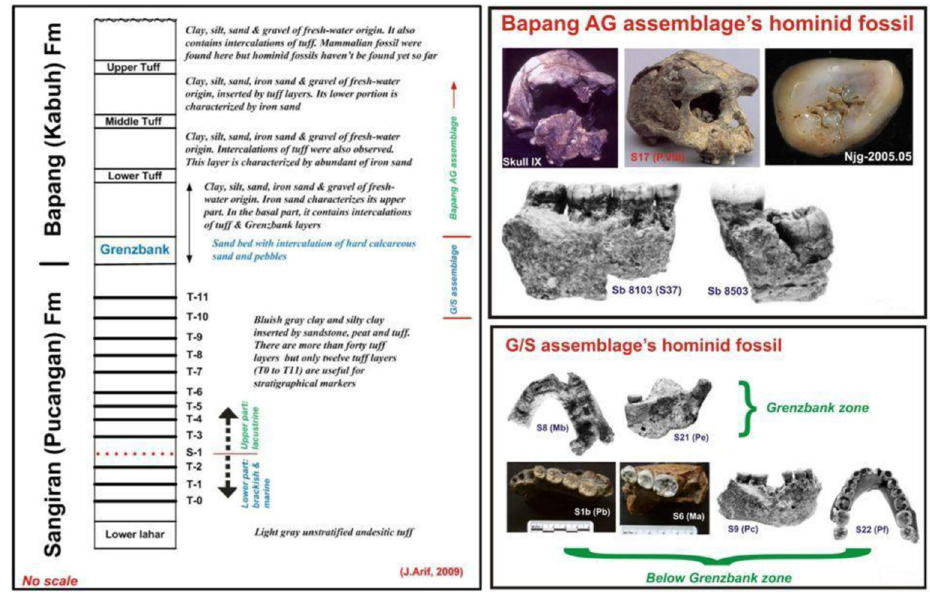
Figure 4. The stratigraphical position of Homo erectus specimens in Sangiran.